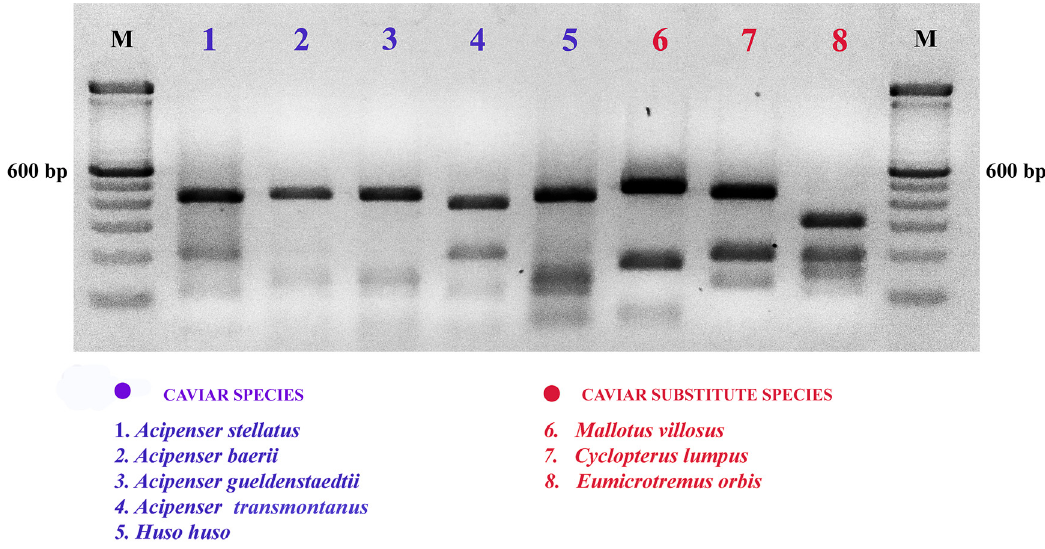
Figure 2. Example of COIBar-RFLP identification on a 3% agarose gel of caviar and substitute caviar species with restriction by MboI of the cytochrome c oxidase I gene. M = molecular weight marker (Trackit TM 100 bp DNA ladder, Invitrogen). All digestion experiments were conducted in triplicate.